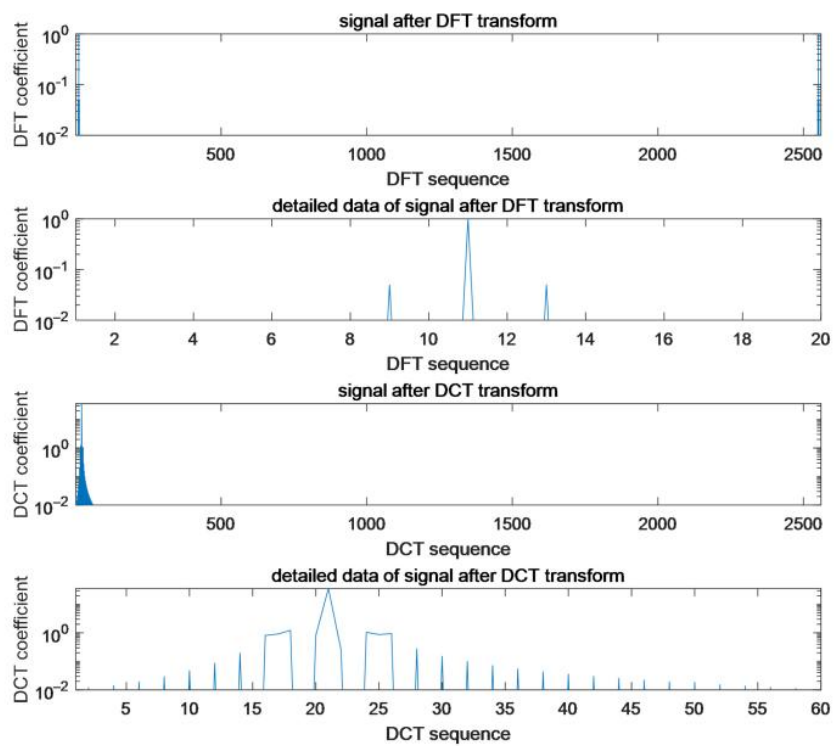
Figure 5. Different transform basis coefficients of the harmonic signal.